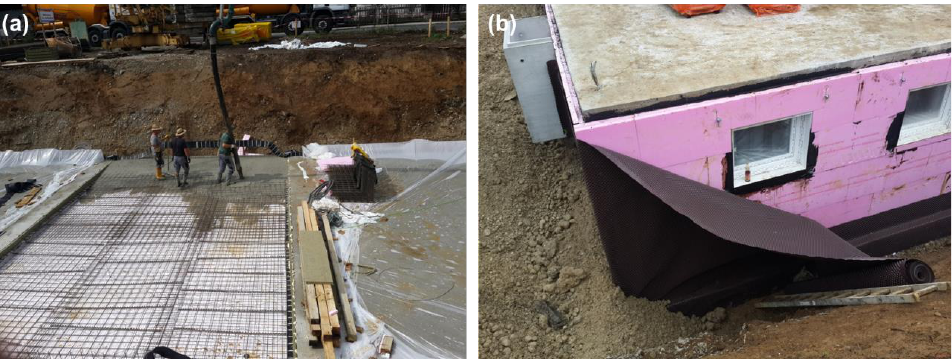
Figure 7. Measures to prevent rising damp on a construction site in Germany: ( a ) measures for a lower ground floor, ( b ) measures for basement walls.